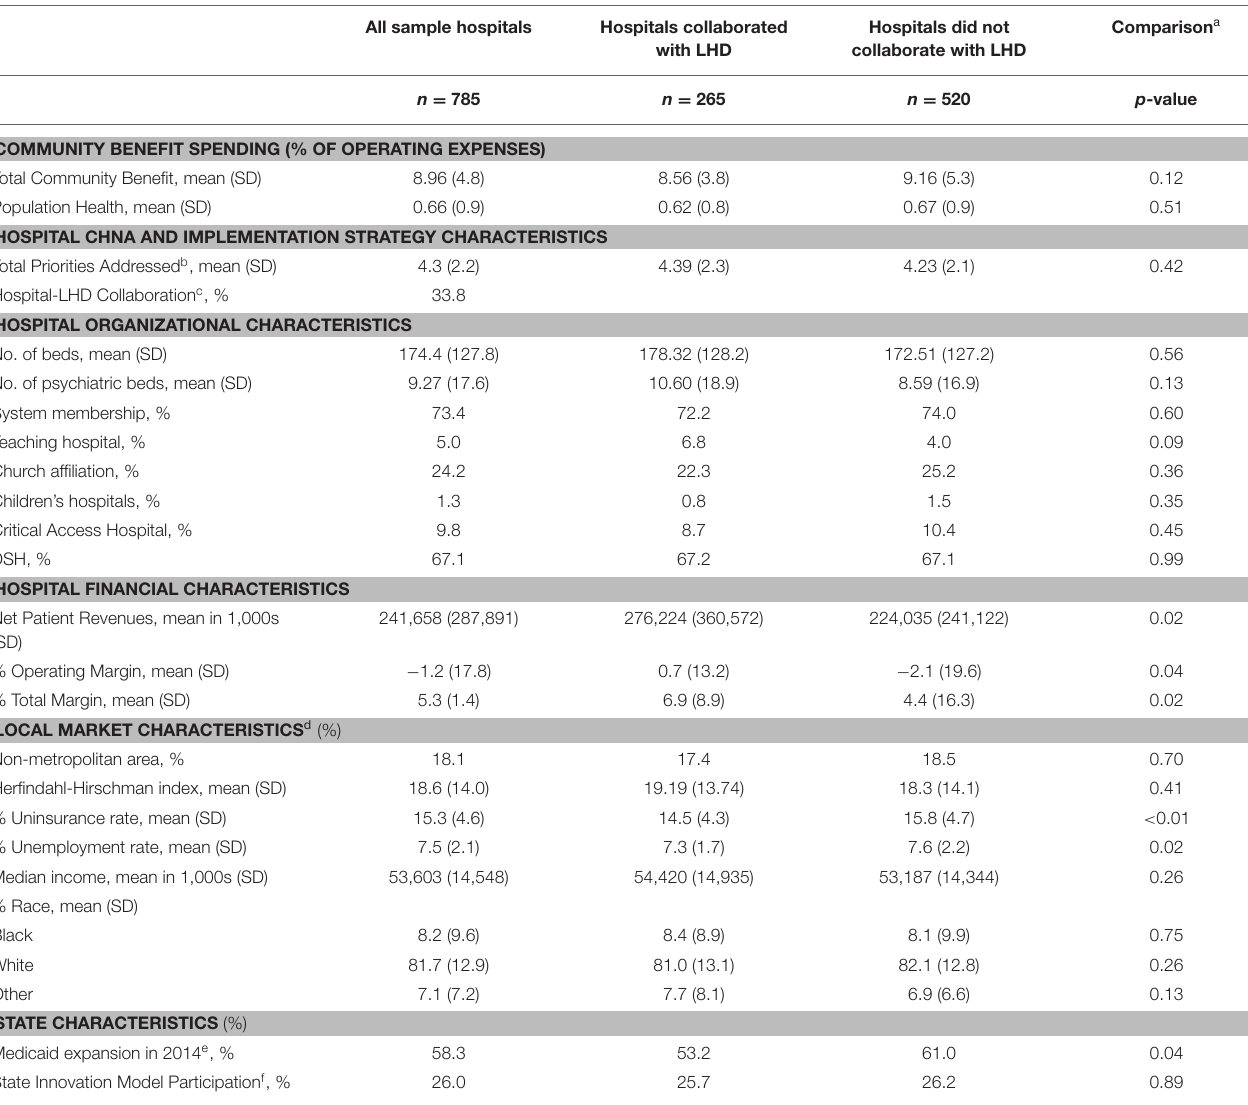
TABLE 2 | Descriptive statistics: non-profit hospital and county- and state-level characteristics.